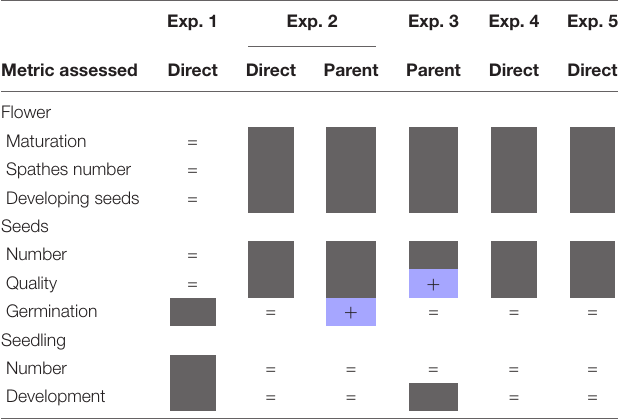
An equal sign (=) shows the metric did not differ between tested CO 2 conditions. A positive sign, highlighted in a blue box, notes high CO 2 benefits the metric assessed. A gray box occurs when a metric was not